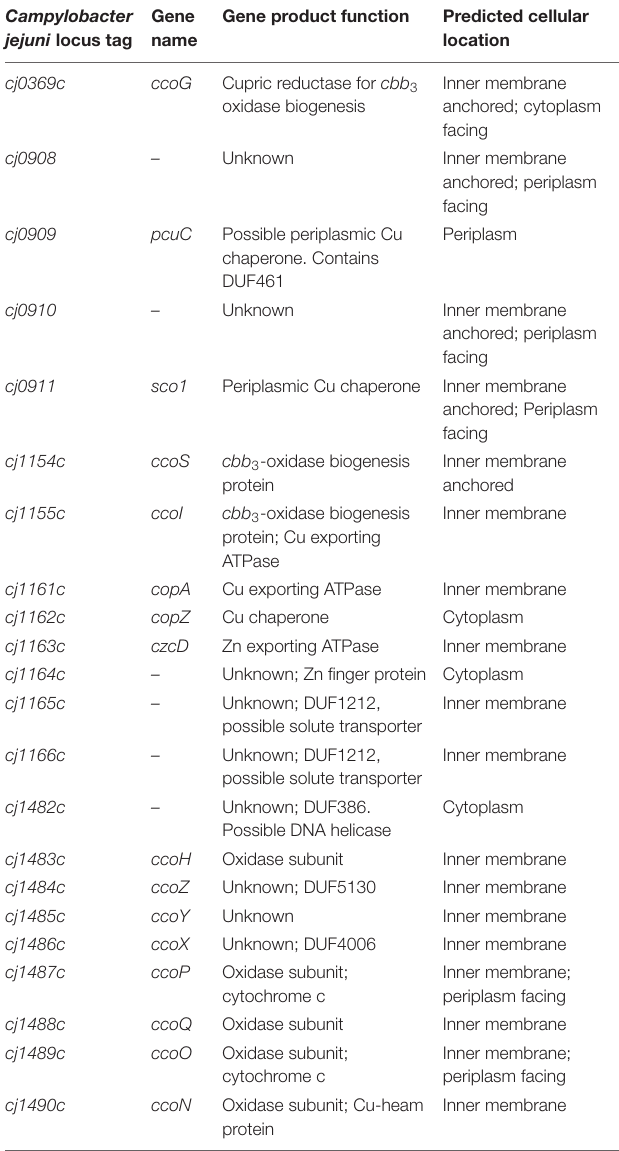
TABLE 1 | Genes tested in this work for their role in oxidase assembly, activity and copper homeostasis. Campylobacter Gene Gene product function Predicted cellular jejuni locus tag name